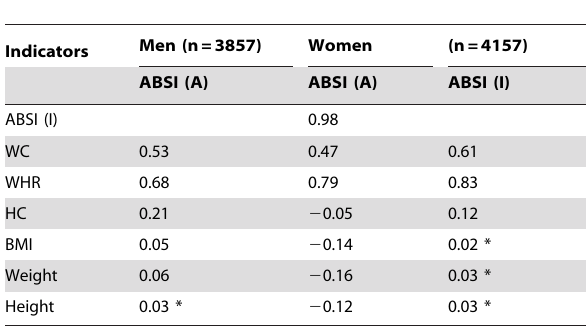
Table 4. Correlation coefficients between ABSI and anthropometric